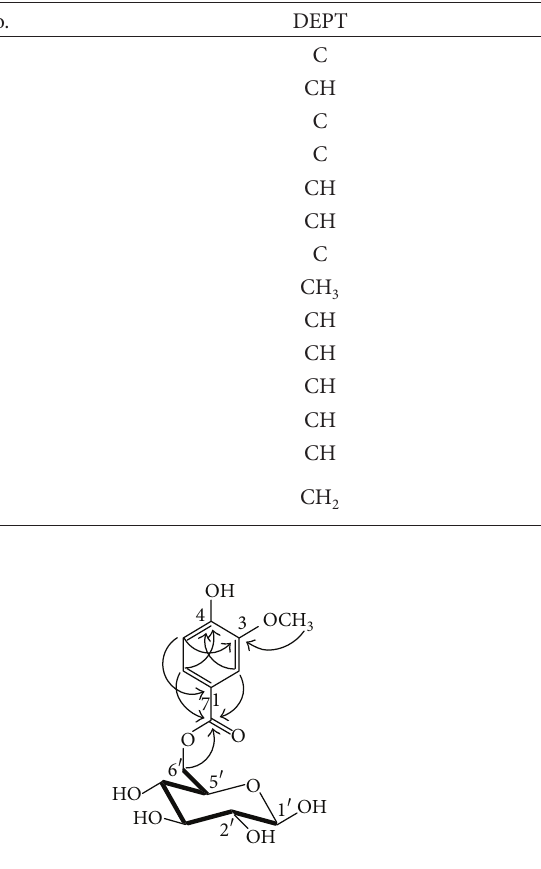
Figure 3: Selected 1 H- 1 H COSY ( — ) correlations in HMBC spectrum (H → C) of 6